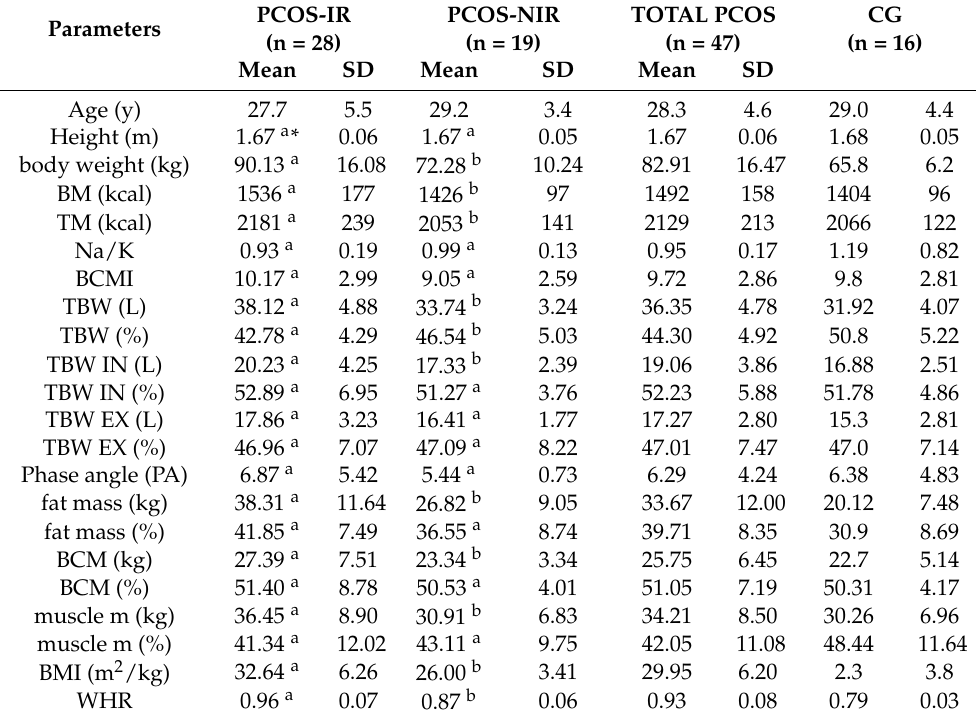
Table 1. Anthropometric characteristics of the study group.